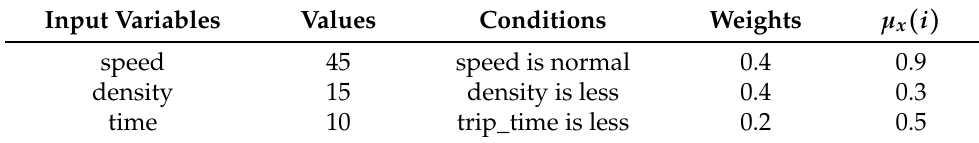
Table 4. Example of calculating the confidence value for the occurrence of a situation ’Low Traffic’.